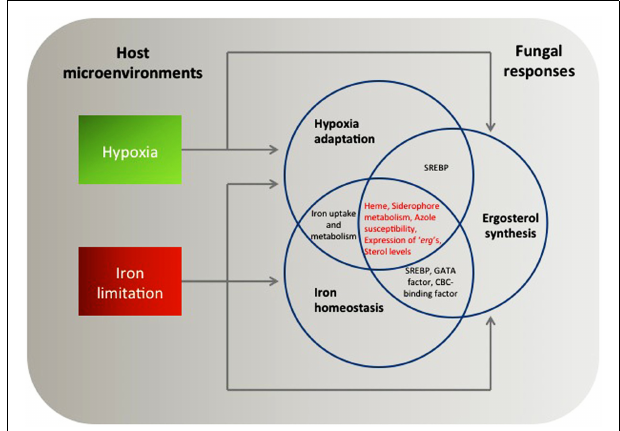
FIGURE 1 |A putative model of coordinated fungal responses to hypoxia and iron limitation based on what is discussed in this review. Transcriptional and phenotypic profiles support how fungi adapt to the host microenvironments interdependently. Arrows indicate transcriptional regulation of key mediators of hypoxia adaptation, iron homeostasis, and ergosterol synthesis in response to either hypoxia or iron limitation. Note that heme, siderophore metabolism, susceptibility to azole drugs, expression of “ erg ” genes, and sterol levels are potential common themes controlled during the fungal adaptation